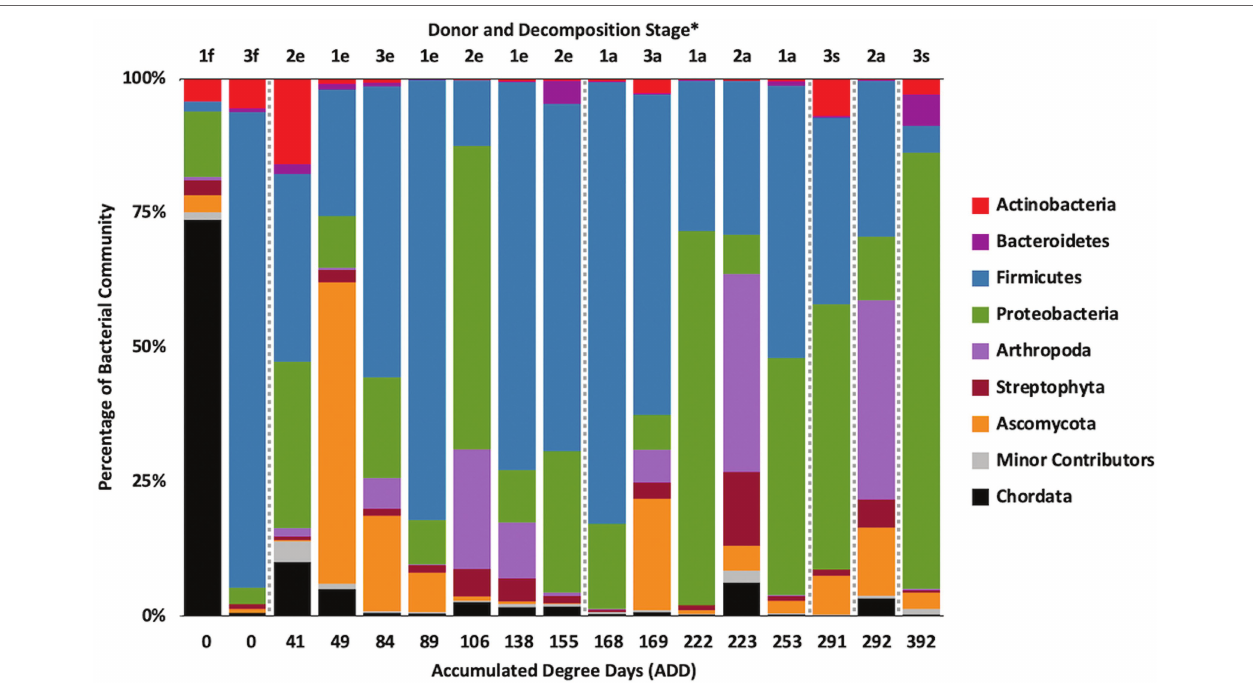
FIGURE 10 | Proportions of bacterial and eukaryotic phyla determined from shotgun metatranscriptomic (MetaT) sequencing from oral samples of three human donors (Donors 1, 2, and 3) during decomposition. Decomposition was assessed as ADD on the x -axis and samples were also classified to an overall decomposition stage for each donor at each sampling event ( * f , fresh; e , early; a , advanced; and s , skeletonized). Minor contributors include data that accounted for <1% of the total diversity within a